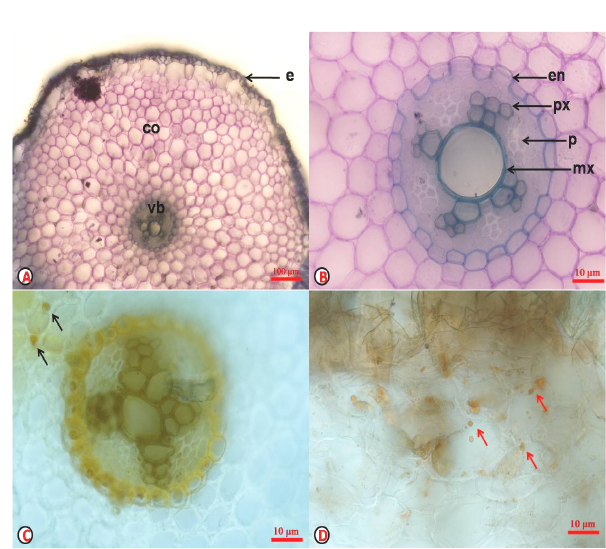
Fig. 6. Transversal section of Allium stracheyi. A) T.S. of bulb just above the shoot apex showing concentric rings of successively older leaves; B) T.S. of a bulb with scape enclosed by leaves; C) Vascular bundle leaf magnified; D) T.S. of outermost leaf showing sclereids; E) Presence of alkaloid (black arrows) in leaf cells; F) Presence of total lipids (red arrows); e - epidermis; sl - sclereid; vb - vascular bundle